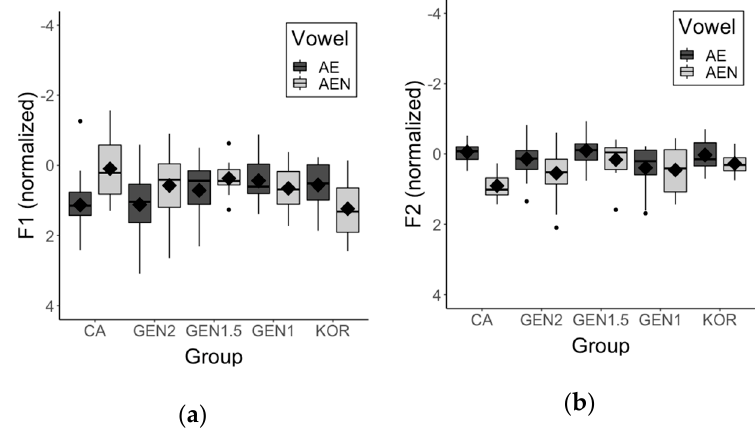
Figure 5. AE and AEN across groups: ( a ) Normalized F1; ( b ) Normalized F2.